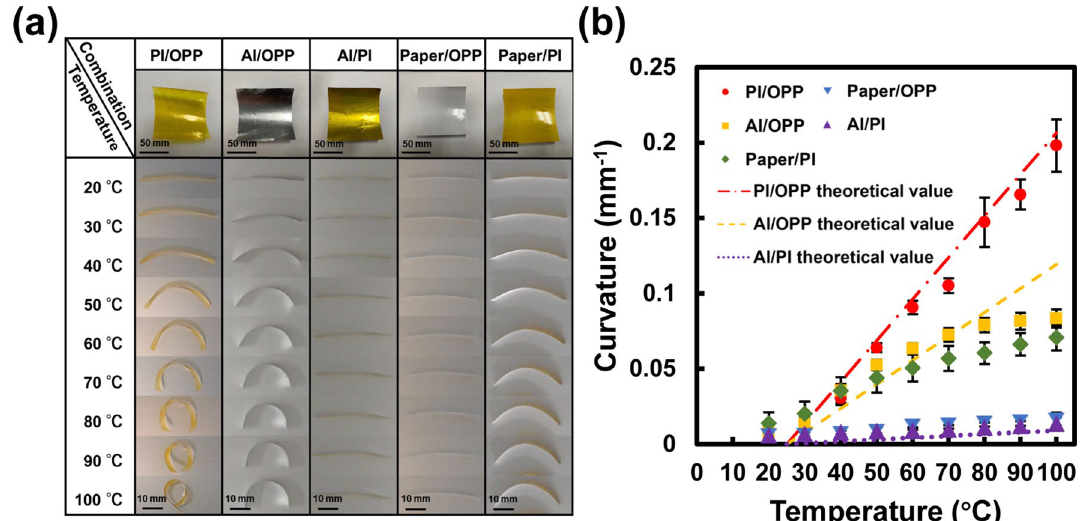
Figure 2. Evaluation of thermal deformation of bimorph actuator films. ( a ) Photographs of fabricated bimorph actuator films and their deformations. ( b ) Relationship between curvature and temperature. Bars represent standard deviation (n =